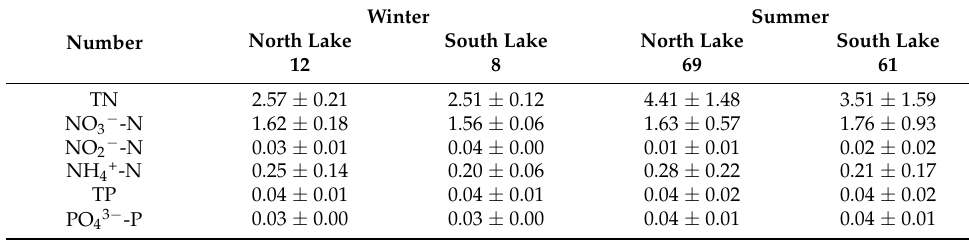
Figure 3. The profile variation of TN ( a ), NH 4+ -N ( b ), NO 2 − -N ( c ), NO 3 − -N ( d ), TP ( e ), PO 43 − -P ( f ), NO 3 − /PO 43 − mole ratio ( g ), and TDS ( h ) of water in Hongfeng Lake during winter (2 January 2017, HF1~HF2) and summer (12 July 2019, HF1~HF6). Red squares and black cycles represented the values in winter and summer, respectively. Table 1. The average concentration of N and P (mg/L) at South lake and North lake of water profiles in Hongfeng Lake during winter and